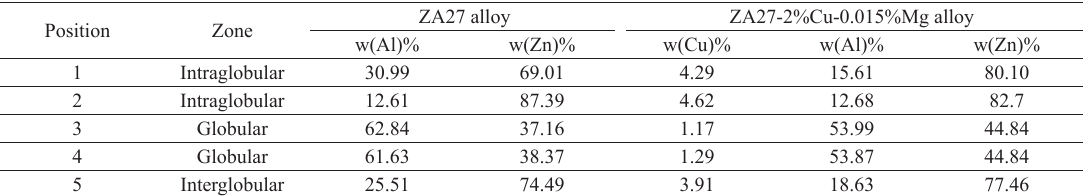
Table 1. Composition of both ZA27 alloys, in different zones at 460°C during 20 min of heat treatment obtained from EDS analysis.